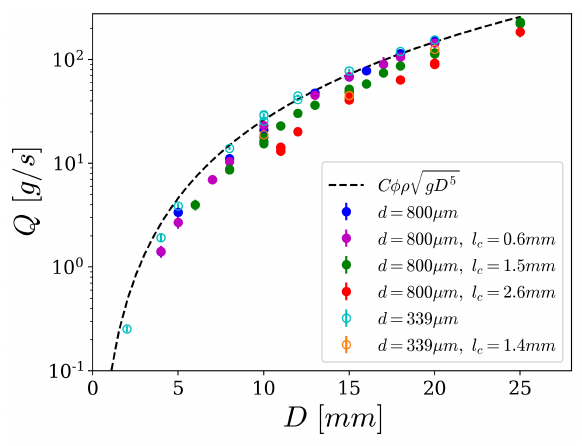
Figure 3. Mass flow rate as a function of the orifice diameter for several cohesions for an axisymmetric silo.